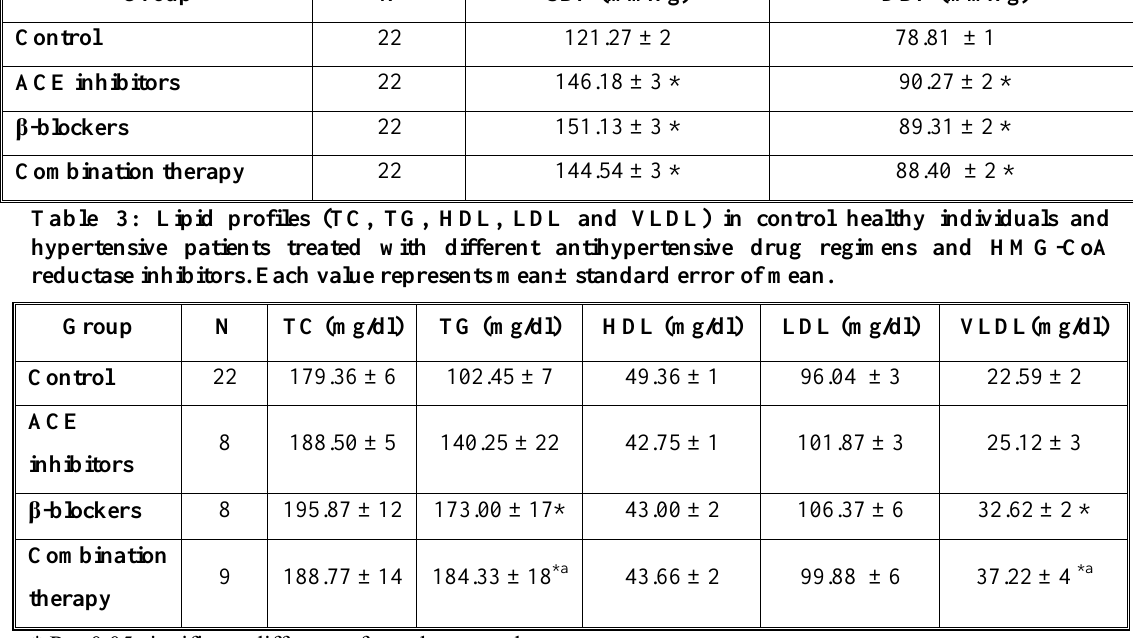
* P ≤ 0.05 significant difference from the control.